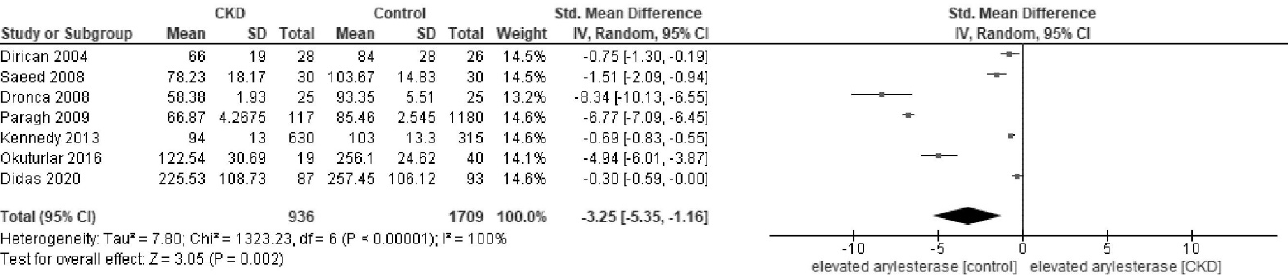
Figure A6. Forest plot of paraoxonase activity in the sensitivity analysis [26–42,44,46–49].